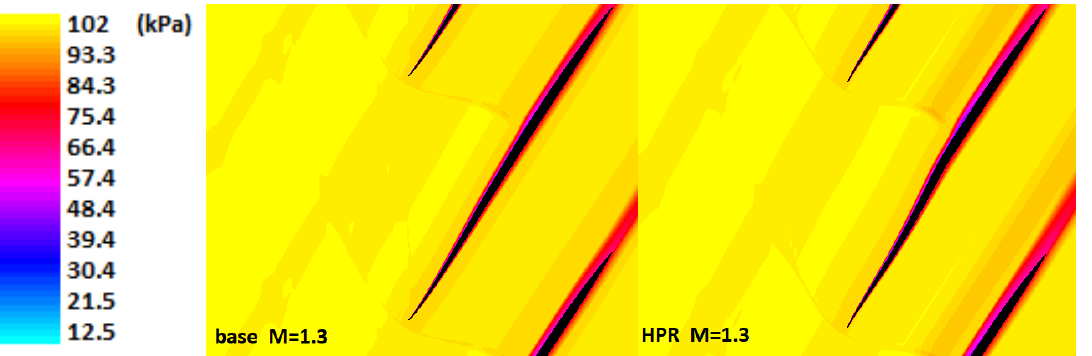
Figure 20. Total pressure contours (kPa) of profiles with HPR at Mach